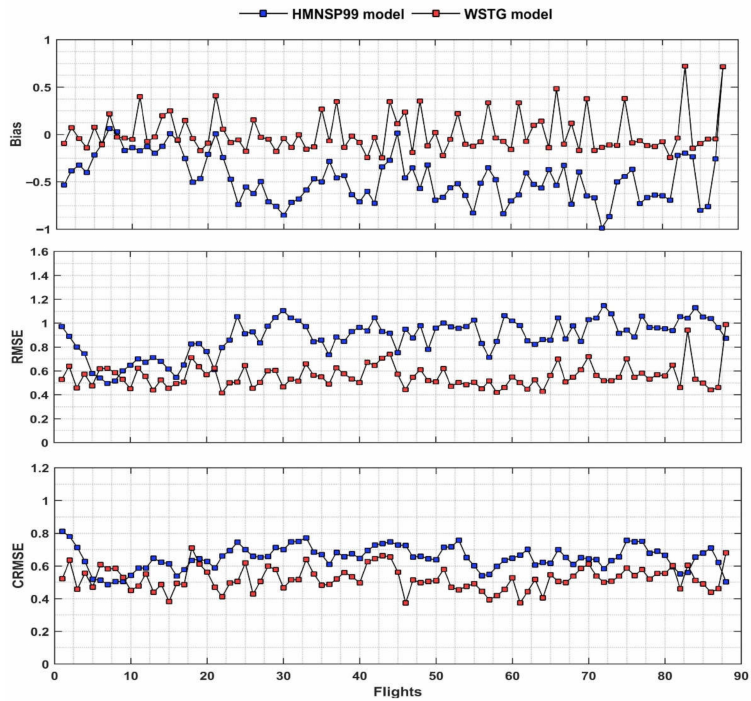
Figure 9. Statistical analysis of log C 2 n calculated by HMNSP99 and WSTG model for eighty-nine flights of individual meteorological